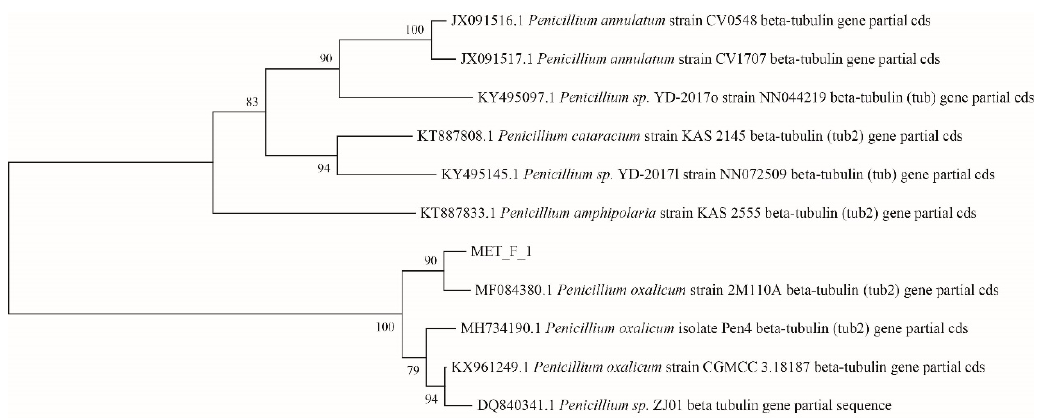
Figure 2. Dendrogram showing the ITS rDNA gene similarity of strain MET-F-1 to several type strains in genus Penicillium . Bootstrap values (%) are given at the nodes. The scale bars represent 0.020 substitutions/site.